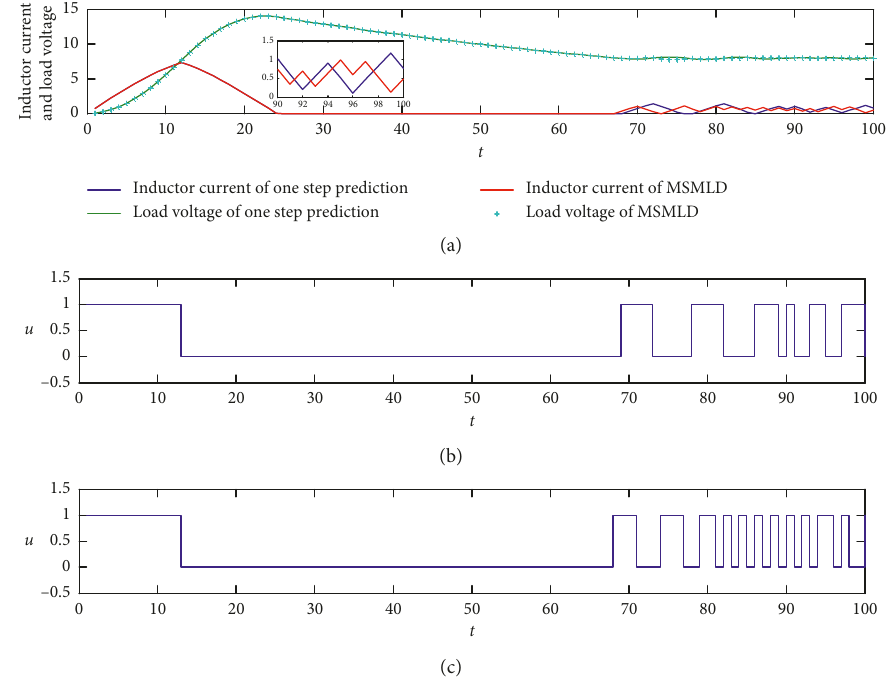
Figure 7: Comparison of SMLD combined with inductor current zero prediction and proposed method. (a) System state of one step prediction and MSMLD. Control input of (b) one step prediction and (c)